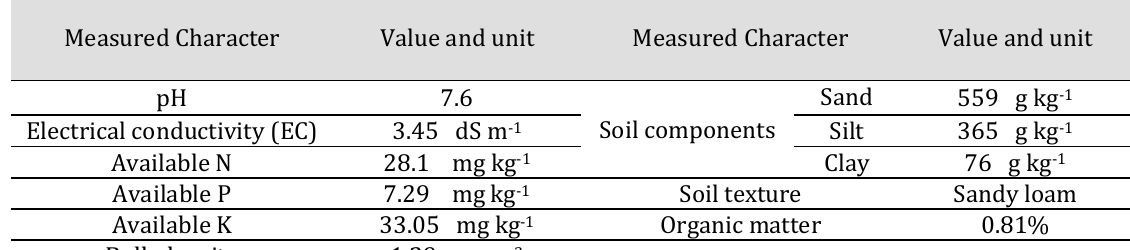
Table 1. Some chemical and physical properties of the